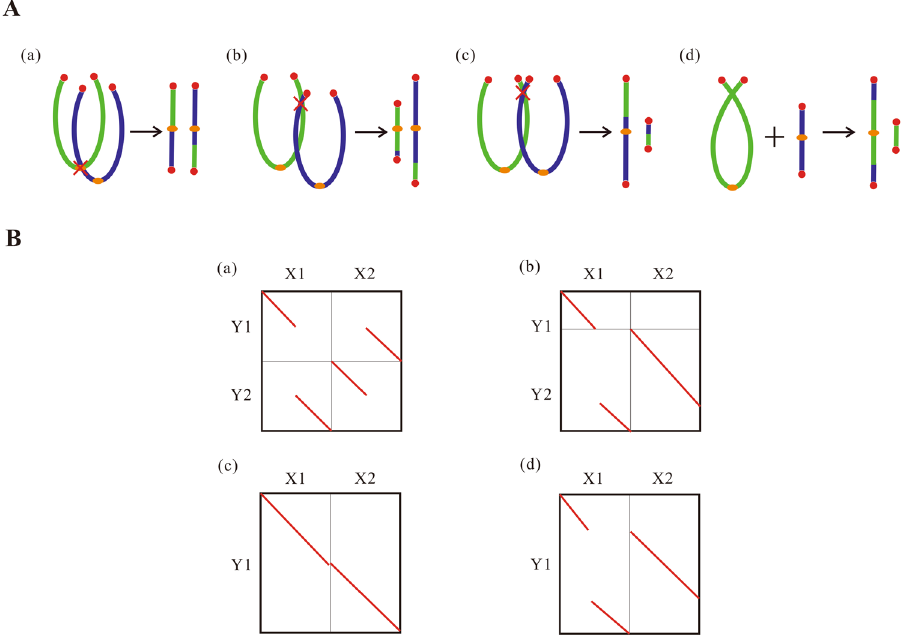
Figure 1. The basic forms of chromosome rearrangement, modified from Meng 27 . ( a ) CIIJ (chromosome inner- inner joining). ( b ) CIEJ (chromosome inner-end joining). ( c ) CEEJ (chromosome end-end joining). ( d ) NCF (nested chromosome